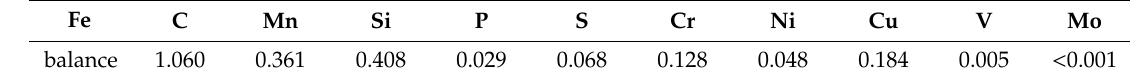
Figure 1. Brief sketch of the MBN measurement. Table 1. Chemical composition of the investigated wires in